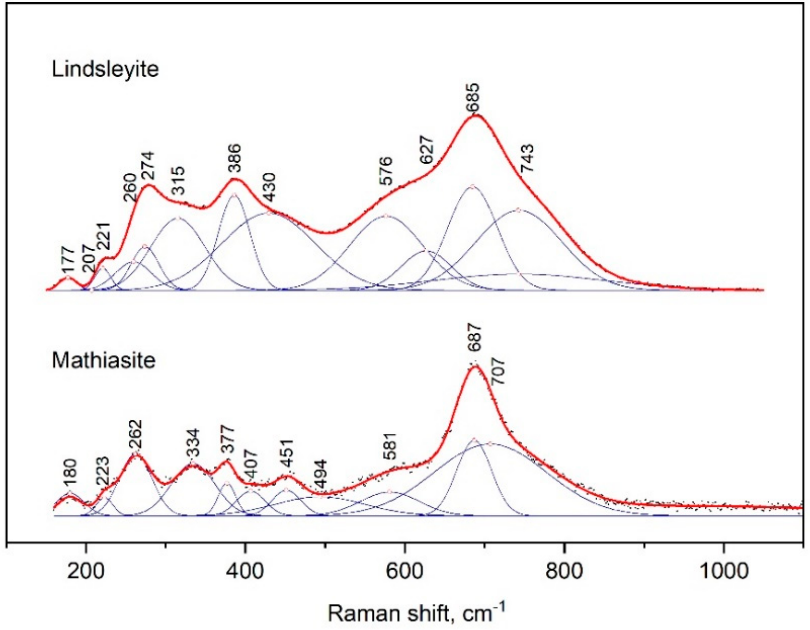
Figure 5. Raman spectrum of synthetic lindsleyite and mathiasite, processed using the Fityk program. The peaks next in intensity were at 377 and 386 cm − 1 , 262 and 274 cm − 1 , 223 and 221 cm − 1 and 180 and 177 cm − 1 for mathiasite and lindsleyite, respectively. The spectrum of mathiasite had addition bands at 334 and 451 cm − 1